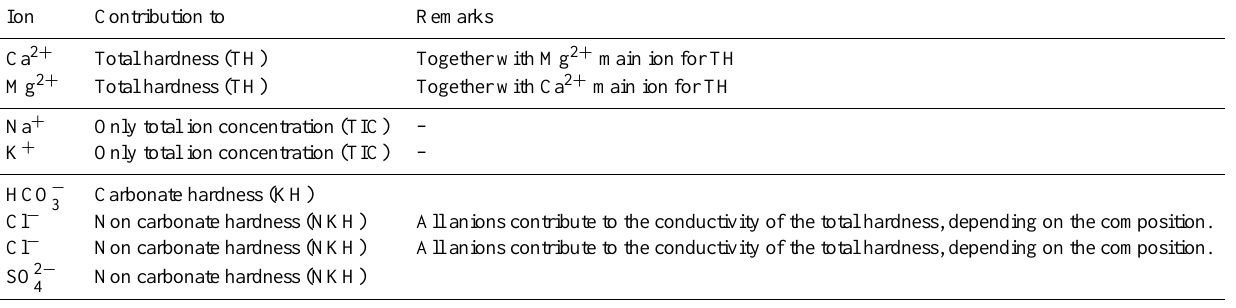
Figure 8. Current response as a function of carbonate hardness.